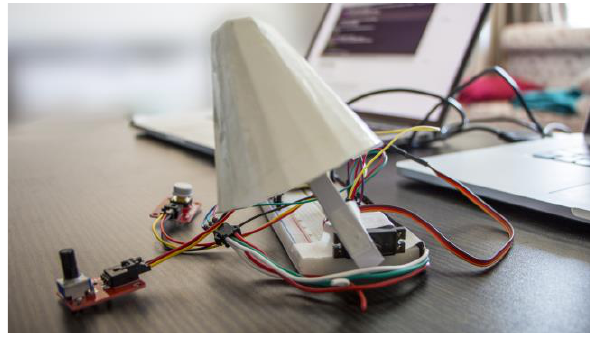
Figure 9 | Low-fidelity and semi-functioning prototype.